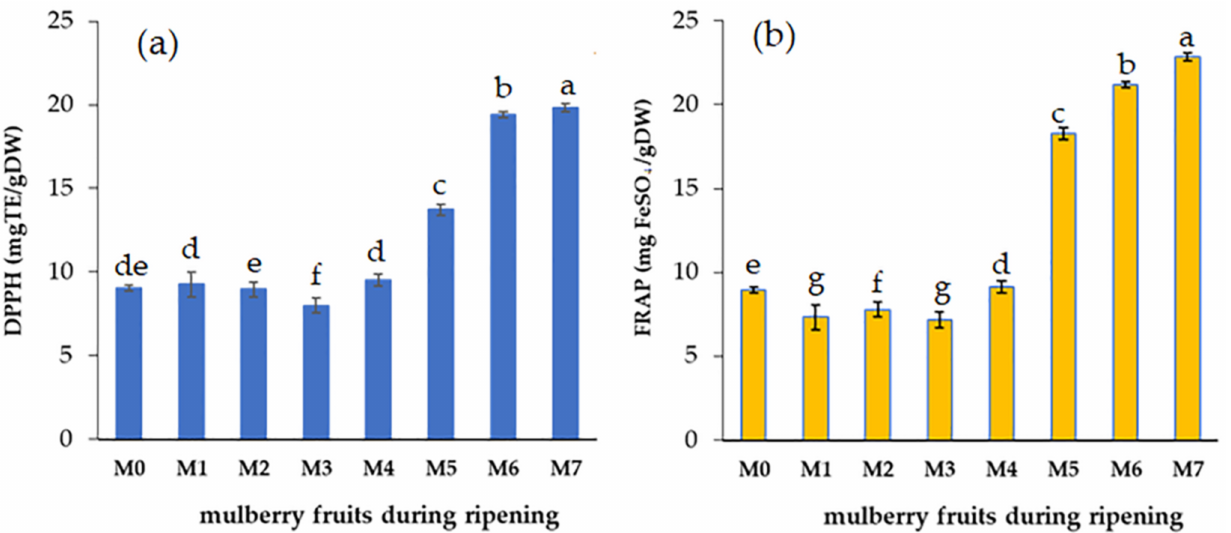
Figure 5. Changes in antioxidant activities measured by means of DPPH radical scavenging ( a ) and FRAP analyses ( b ) of mulberry fruit during different ripening stages. M0–M7 are mulberry fruit during different ripening stages; means with different letters (a–g) are significantly different at p < 0.05 within the same